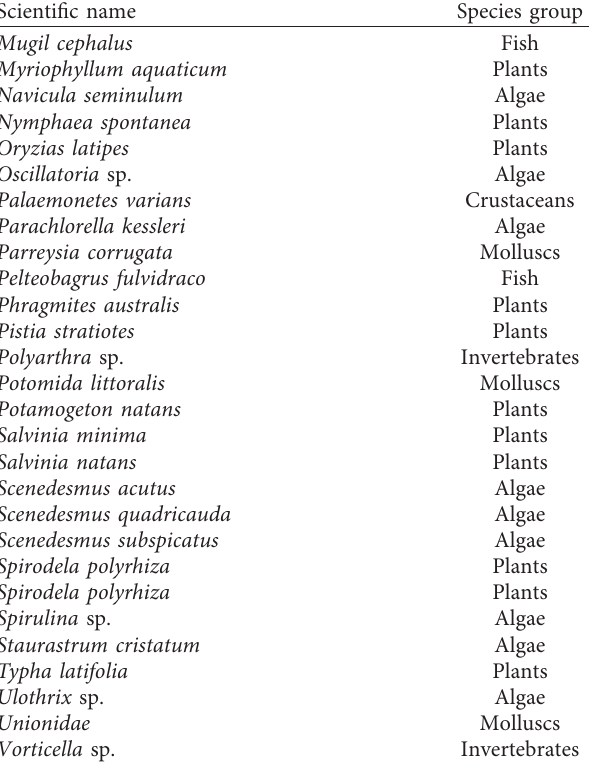
Spirodela polyrhiza Plants Spirulina sp. Algae Staurastrum cristatum Algae Typha latifolia Plants Ulothrix sp. Algae Unionidae Molluscs Vorticella sp.